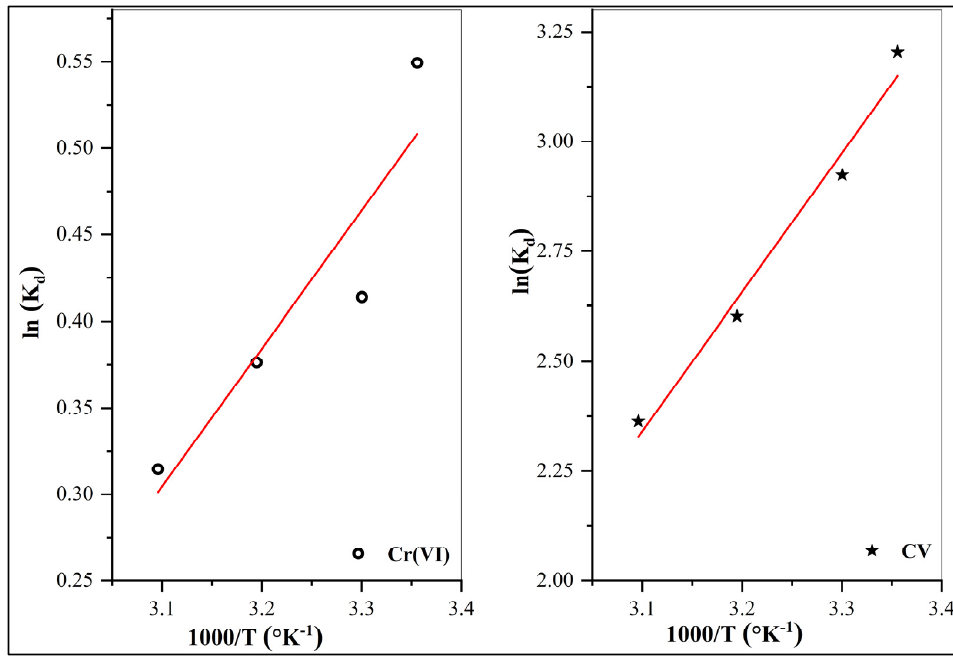
Figure 15. Evolution of ln (K d ) as a function of 1/T. Table 7. Thermodynamic parameters of Cr (VI) and CV adsorption on ACSCGs.